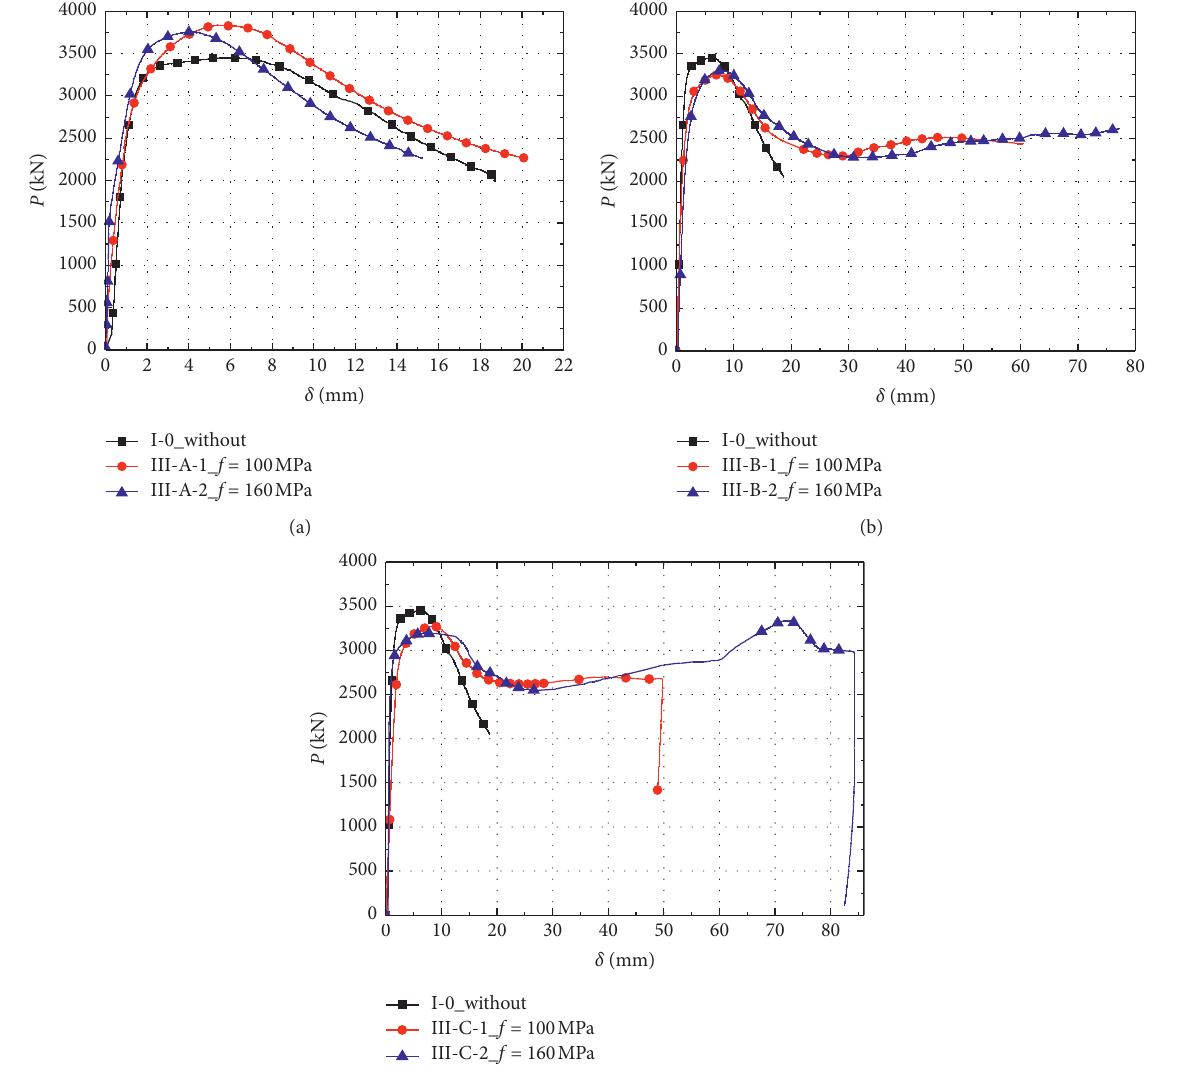
Figure 10: Effects of strength of LYP steel plate. (a) Type III-A specimens. (b) Type III-B specimens. (c) Type III-C